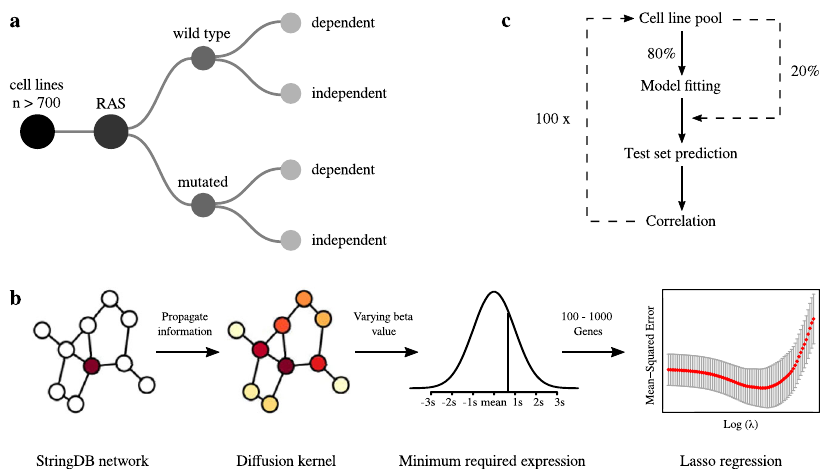
Fig. 1 Cancer cell line classi fi cation algorithm and gene dependency modeling strategies. a Strategy of cell line subgrouping leading to the investigated subgroups (HRAS wt /HRAS mut , KRAS wt /KRAS mut , NRAS wt /NRAS mut ). b Variable selection work fl ow for whole transcriptome RNA-expression data consisting of the construction of a literature-based gene network followed by further selections steps with centrality quanti fi cation through a diffusion kernel and a minimum required expression level. Several different constellations of the hyperparameters were tested. Final modeling was performed using a Lasso, Elastic Net or Random Forest regression. c Work fl ow of iterative model fi tting and performance evaluation for each gene dependency